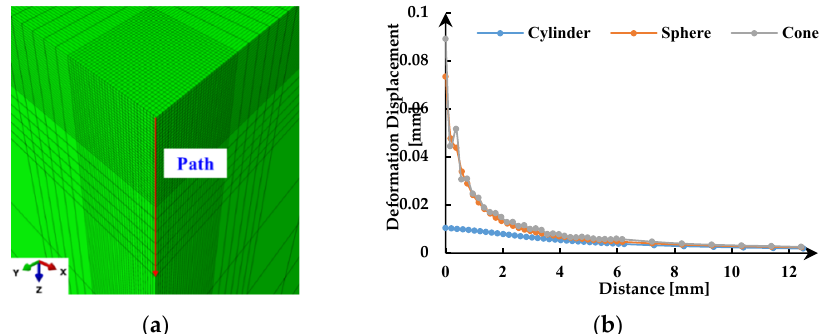
Figure 15. Comparison of deformation displacement of three types of indenters under static-dynamic loads: ( a ) The selected path in the vertical direction of the rock. ( b ) Deformation displacement versus distance from the rock surface.